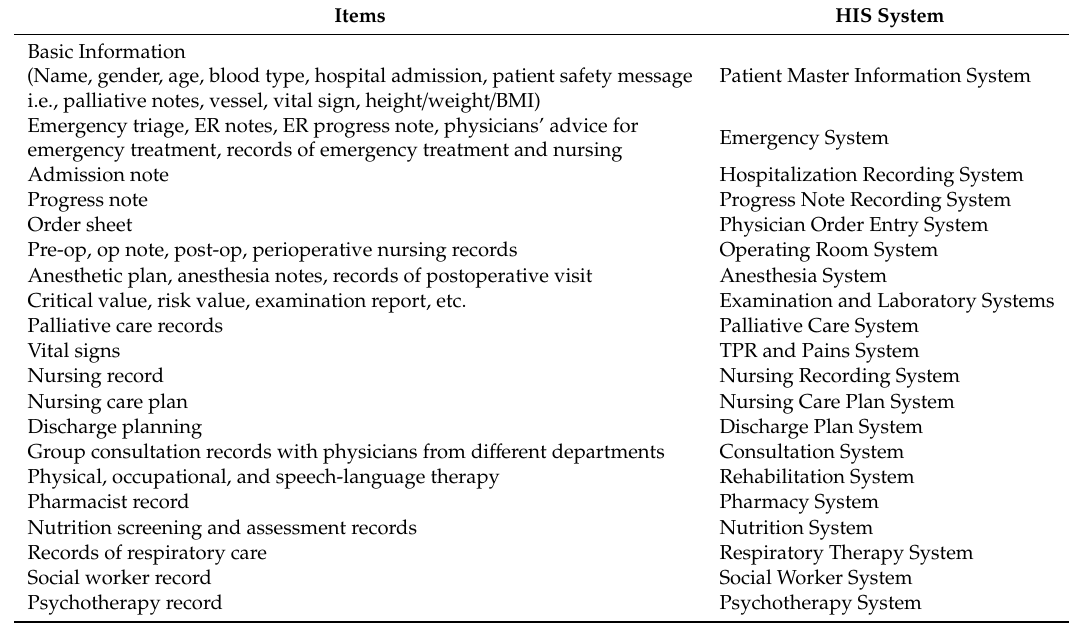
Table 1. Information that needs to be shared among the medical team members and their sources.